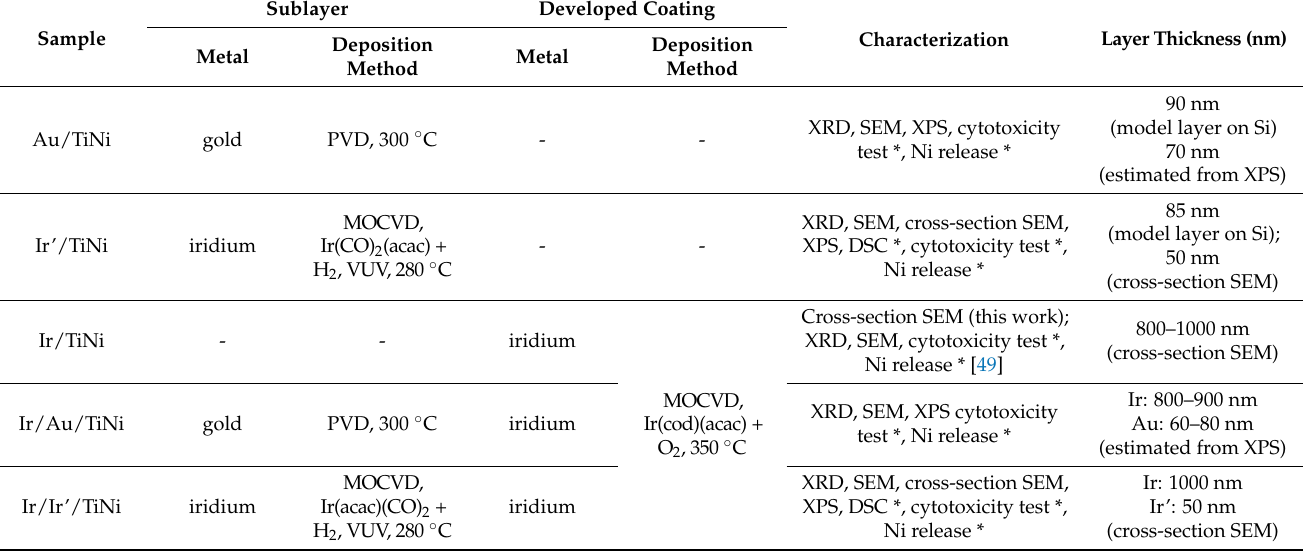
Table 1. Summarized information for TiNi substrates coated with noble metal film materials discussed in this